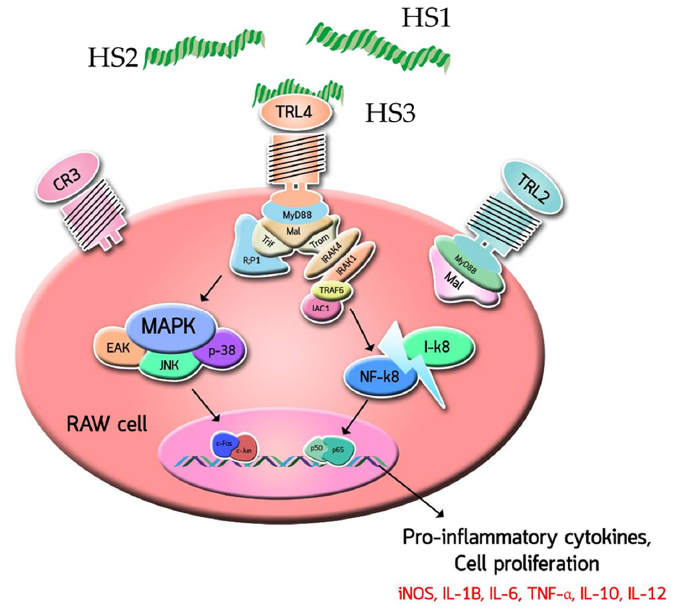
Figure 6. A schematic illustration of the interaction of low molecular weight binding to